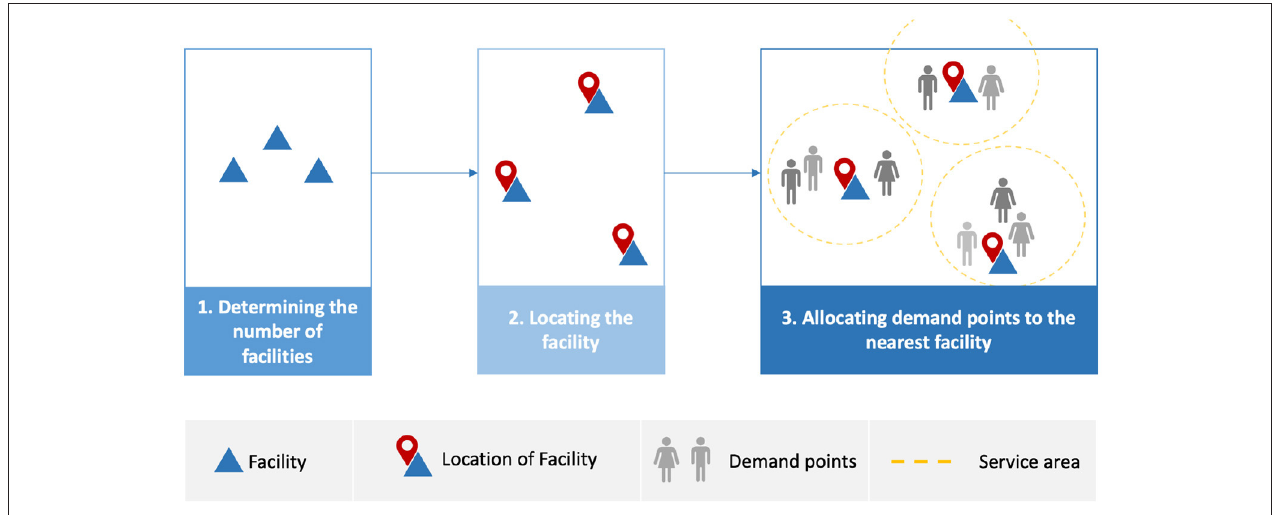
FIGURE 1 | Workflow for location-allocation